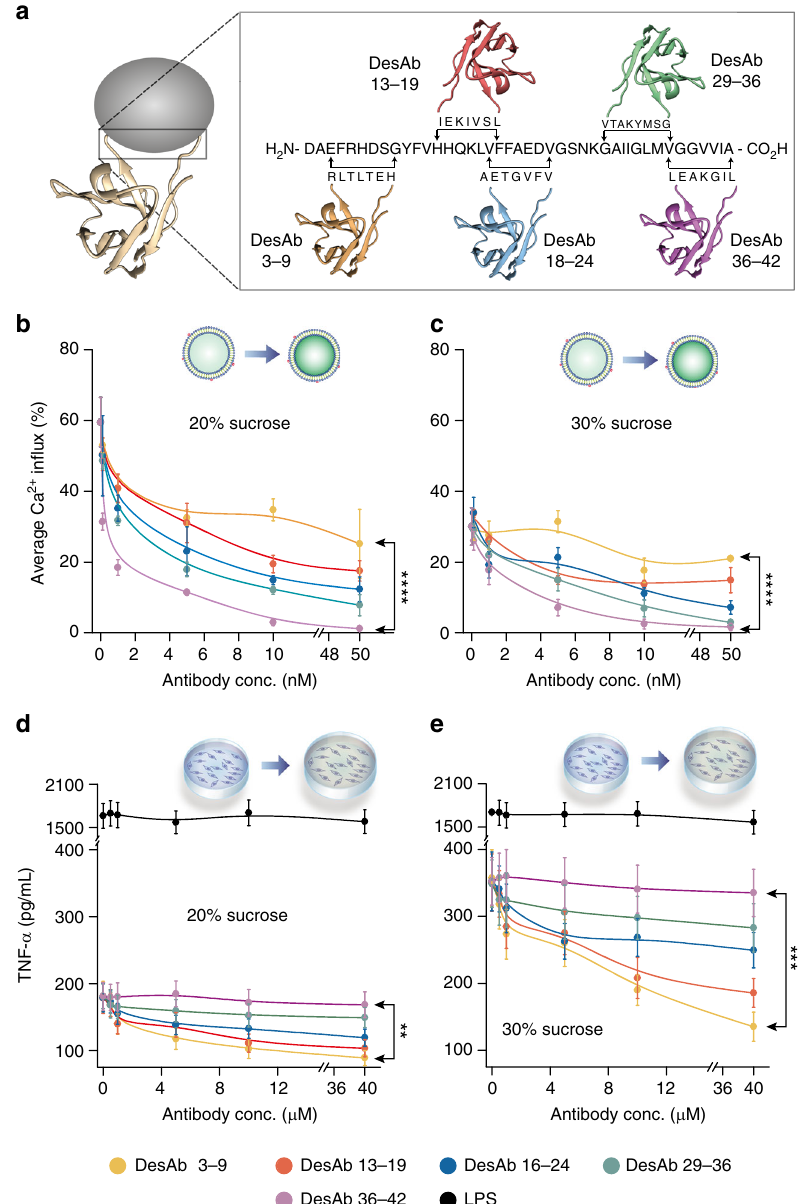
Fig. 6 In fl uence of the different sequence regions of A β 42 on its toxicity mechanisms. a We used fi ve rationally designed antibodies that target different epitopes of the A β 42 sequence. The antibodies DesAb 3 – 9 and DesAb 36 – 42 bind to the N-terminal and C-terminal regions of A β 42, respectively. Representative experiments showing the concentration of each antibody ( x -axis) added to aggregates present in solutions at b and d 20% and c and e 30% sucrose and the reduction of aggregate-induced toxicity. The error bars represent the standard deviation among the fi eld of views ( b , c ) and among the well ( d , e ). Antibodies that target C-terminal regions of A β 42 are more effective at reducing the membrane permeability induced by A β 42 aggregates. Antibodies that target N-terminal regions of A β 42 are more potent in reducing the in fl ammatory response induced by A β 42 aggregates ( d , e ). As a positive control, we used lipopolysaccharides (LPS), which is known to induce TNF- α production in microglial cells. For each case, P values are calculated using two-sample t -test to compare the inhibition by most N-terminally binding antibody (DesAb3 – 9) and C-terminally antibody (DesAb36 – 42) at their highest concentration (two biological repeats n = 2, the lines are simply guides to the eye). Source data of b – e are provided as a Source Data fi fl uorescent impurities. Each cover slide was fi xed by frame-seal incubation times through a membrane with a size cut off of 200 nm and size of the vesicles chambers (Biorad, Hercules) and the surface was coated with 100:1 PLL-g-PEG and were measure using a Zetasizer (Zetasizer Nano ZSP). Free dyes were removed PLL-g-PEG biotin (SuSoS AG) (1 g/L) in 50 mM HEPES buffer. Then the cover using size exclusion chromatography. slides were washed three times and 0.1mg/mL neutravidin (Thermo Scienti fi c) The single vesicle based assay was used to measure the permeability of lipid solution was added to the cover slide and incubated for 15 min and washed three bilayers in presence of toxic protein aggregates 19,49 . Glass cover slides (VWR times with reaction buffer. Then, a 50 µL aliquot of the solution of puri fi ed International, product number 63 1-0122) were cleaned by sonicating in 2% (v/v) biotinylated vesicles was added to the cover slide and incubated for 30 min before Hellmanex III (Hellma GmbH & Co. KG) in milliQ water for 10 min followed by washing carefully at least fi ve times with reaction buffer. Single vesicles tethered sonicating twice in milliQ water and in methanol for 10min each. Then the cover to borosilicate glass cover slides via biotin neutravidin linkage were incubated slides were dried under a stream of nitrogen gas, and plasma-etched using an argon with 50µL Ca 2 + containing buffer solution Leibovitz ’ s L-15 (phenol red free) and plasma cleaner (PDC-002, Harrick Plasma) for at least 30min to remove any